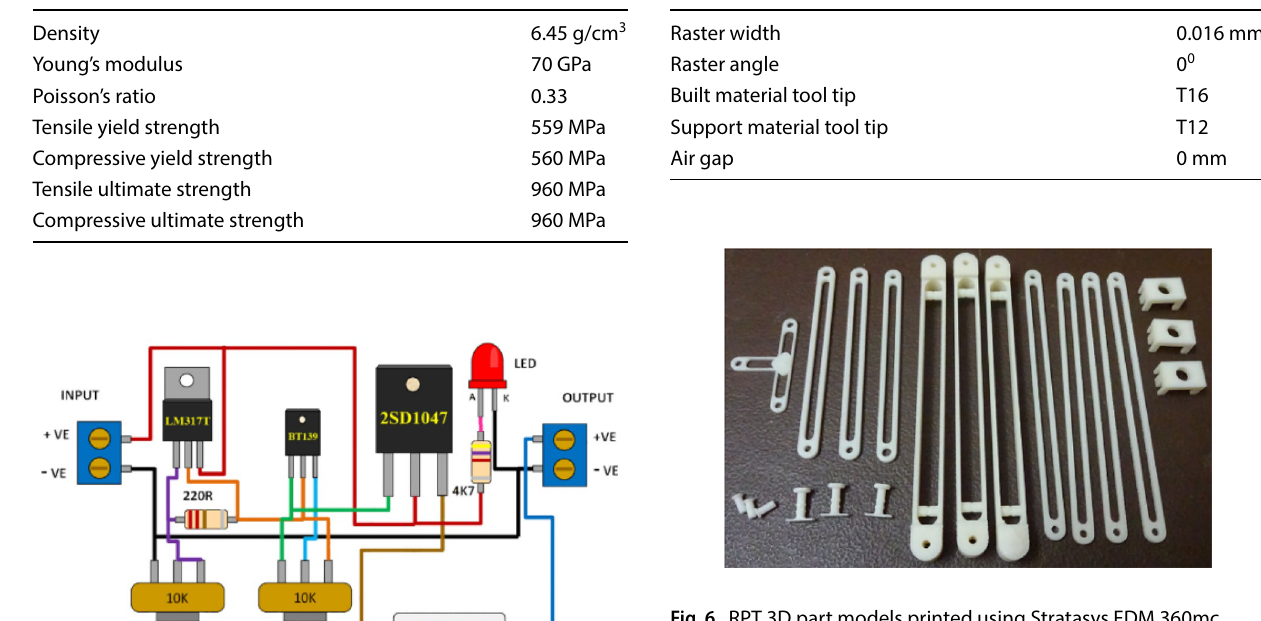
Fig. 6 RPT 3D part models printed using Stratasys FDM 360mc